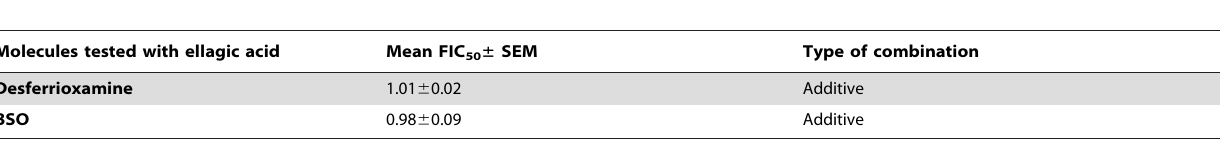
Table 2. Effects of D,L-Buthionine- (S,R) sulphoximine (BSO) and desferrioxamine in combination with ellagic acid on the FcM29 strain.